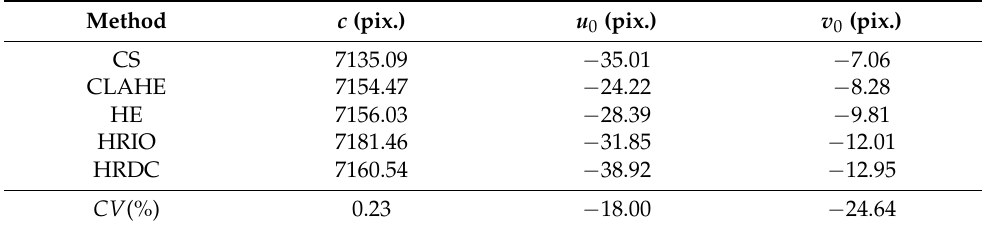
Table 5. High-speed system internal parameters measured from the photogrammetry process using enhanced